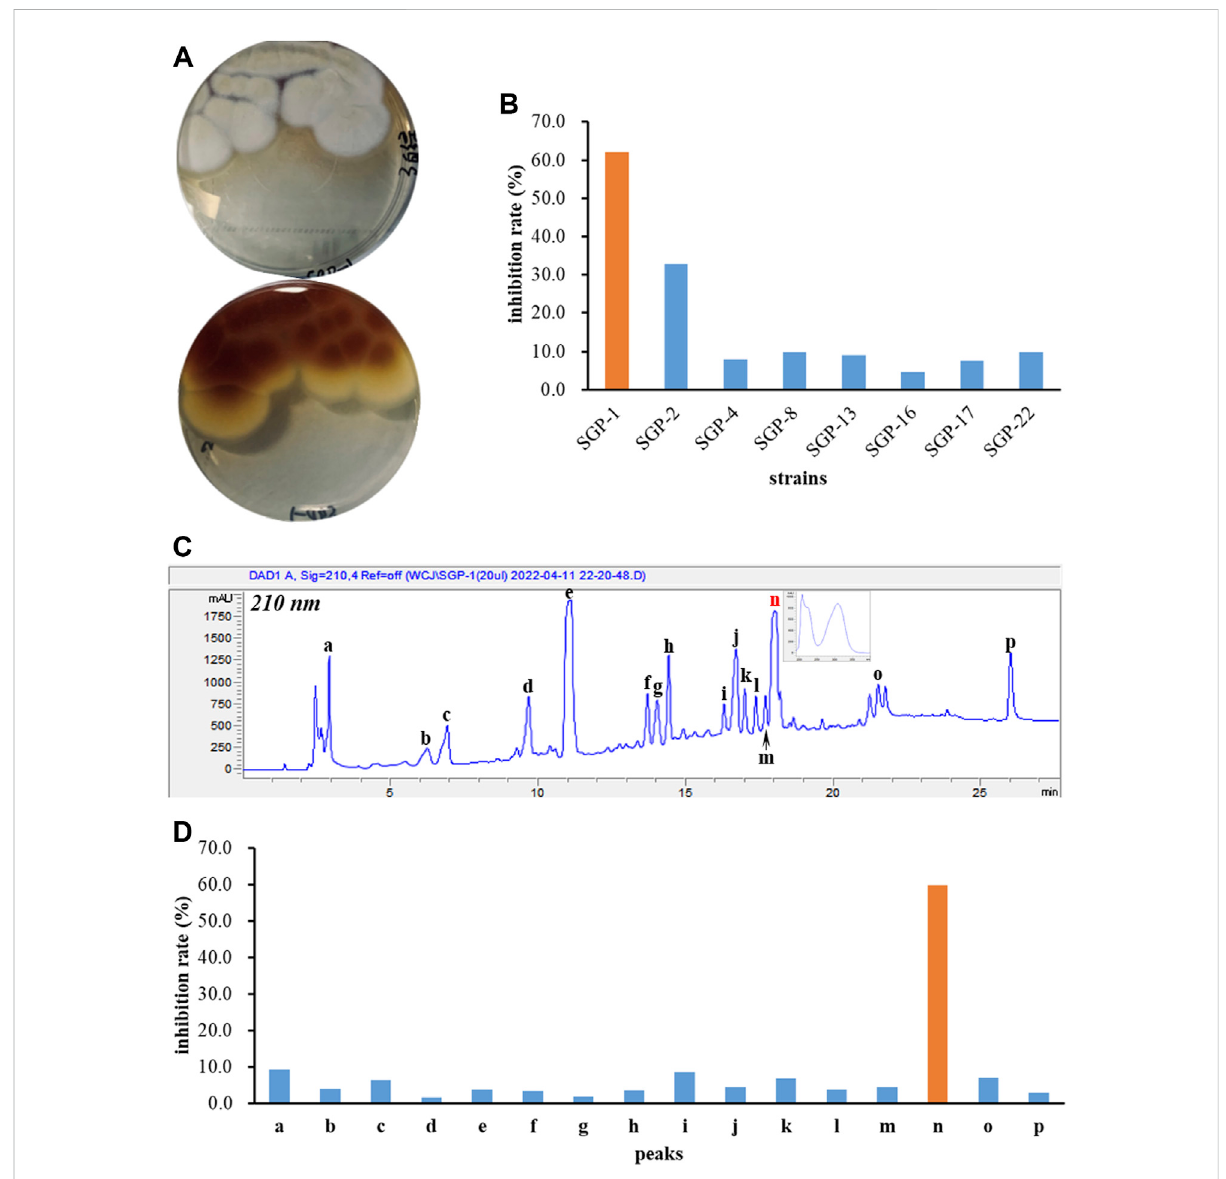
FIGURE 1 BChE inhibition screening of fungal strains and secondary metabolites. (A) Colonial morphology of Aspergillus terreus SGP-1; (B) BChE inhibitory activity of eight endophytic fungal strains; (C) HPLC preparation of the chemical constituents of SGP-1 EtOAc extract; (D) BChE inhibitory activity of SGP-1 chemical